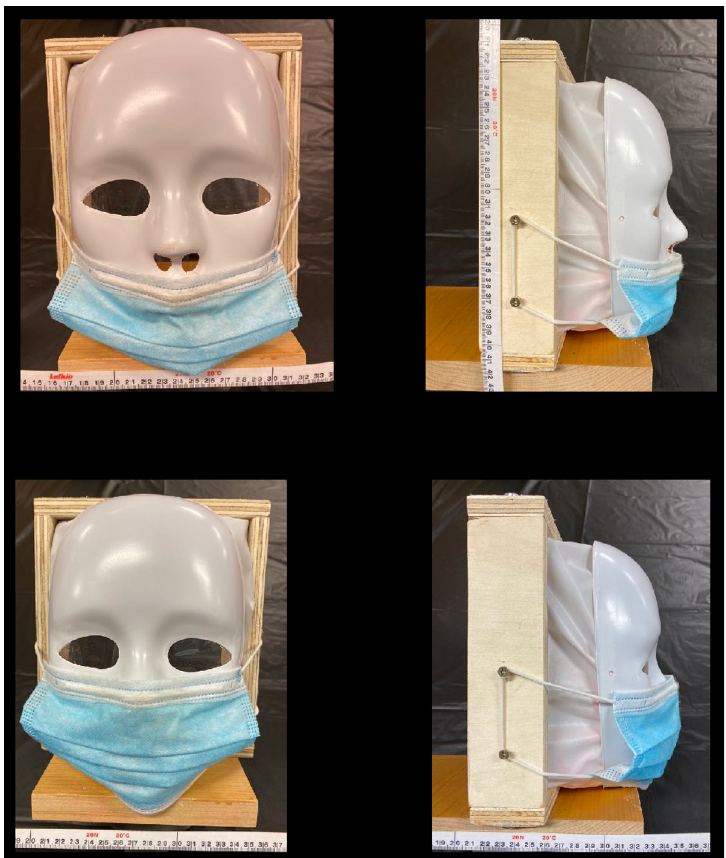
Fig 8. Frontal and side view of M1 wearing a mask in different positions. A white metric measuring tape with centimeter and millimeter markings is positioned in each figure. (A) The Frontal view of M1 wearing a surgical mask improperly is displayed. (B) The side view of M1 wearing a surgical mask improperly is shown. (C) The frontal view of M1 wearing a surgical mask properly is presented. (D) The side view of M1 wearing a surgical mask properly can be seen.